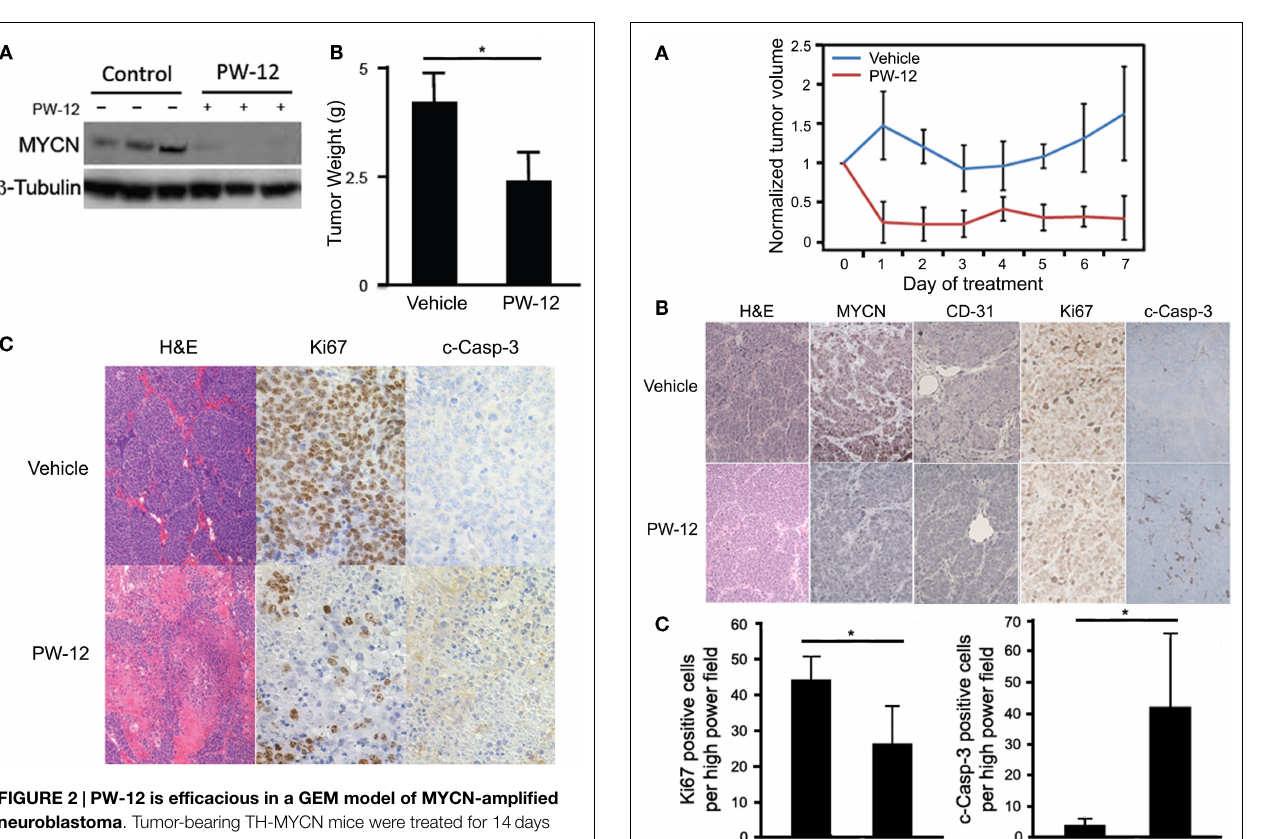
PI3K Inhibition by PW-12 has Efficacy in a TH-MYCN Model of Neuroblastoma Using the TH-MYCN neuroblastoma mouse model in which human MYCN is expressed under control of the mouse tyrosine hydroxylase promoter, we are able to generate mouse neuroblas- toma tumors with high penetrance, which are genetically, histo- logically, and morphologically similar to human neuroblastomas (24). Abdominal tumors were detected in TH-MYCN mice by pal- pation and either PW-12 (25 mg/kg) or vehicle alone was admin- istered by IP injection daily for 14 days. PW-12 treated tumors demonstrate a significant decrease in MYCN protein expression and in tumor mass ( p < 0.05) when compared to vehicle treated controls( Figures2A,B ),consistentwithdirectblockadeofMYCN and subsequent anti-tumor effects. They also showed decreased cellularity, decreased proliferation measured by Ki-67